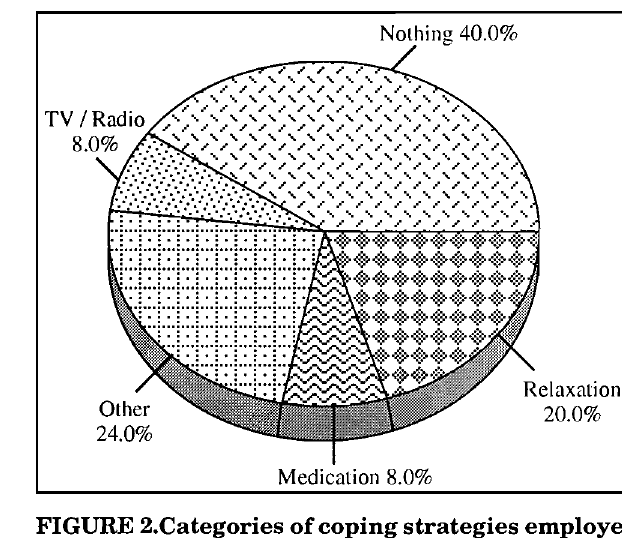
TABLE 6: Factors perceived to make tinnitus worse (N=61) Factors that aggravate tinnitus